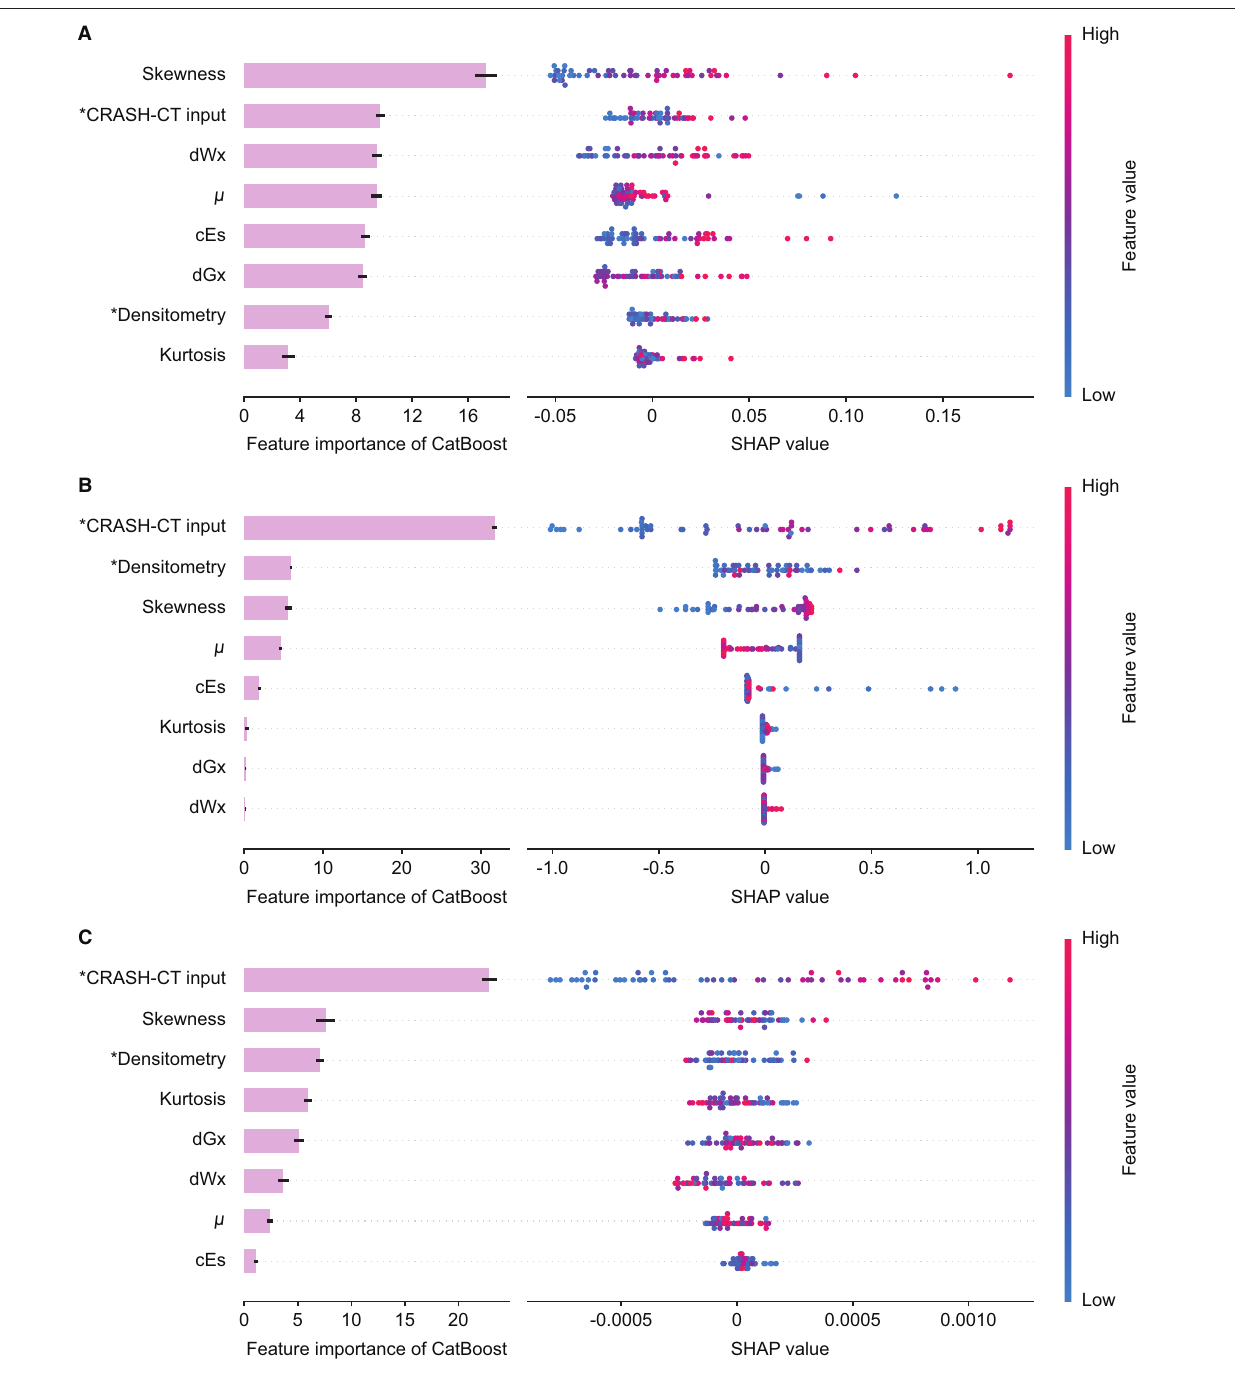
FIGURE 8 | Feature importance and SHAP value of the D/CRASH-CT CatBoost model for the differentiation of alternative outcome measures: in-hospital mortality (A) , length of stay (B) , and need for surgical intervention (C) . Each row shows the distribution of SHAP values assigned to a model input. Asterisks denote input variables that have undergone dimensionality reduction by principal component